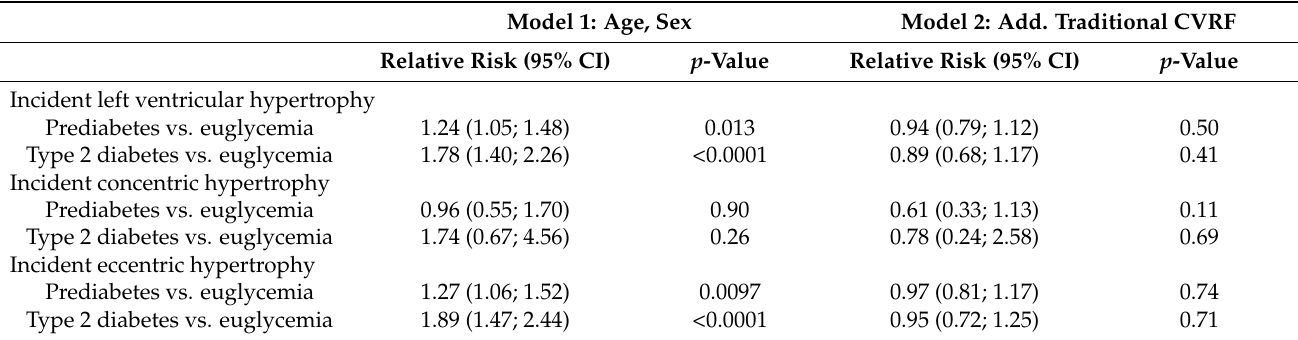
Figure 3. Incidence of LVH in prediabetes and type 2 diabetes mellitus. Illustration of a multiple Poisson regression analyses with incidence of LVH as a dependent variable and prediabetes as well as T2DM as independent variables adjusted for age and sex. CI: confidence interval. LVH: left ventricular hypertrophy. RR: relative risk ratio. T2DM: type 2 diabetes mellitus. Table 4. Relevance of prediabetes and type 2 diabetes for the incidence of LVH. Model 1: Age, Sex Model 2: Add. Traditional CVRF Relative Risk (95% CI)